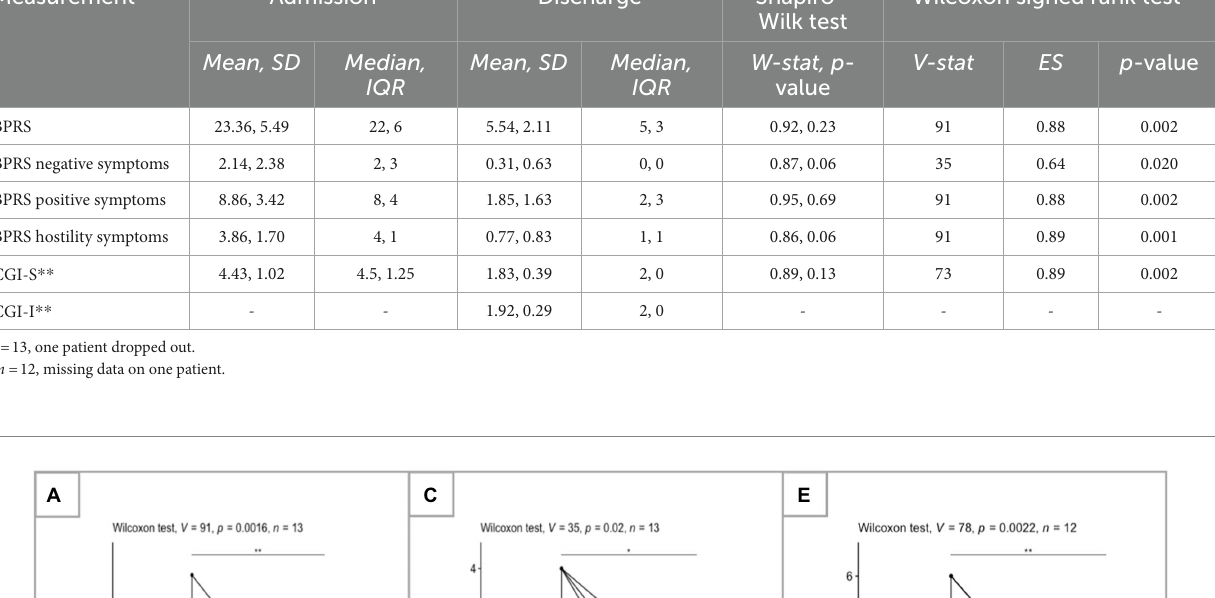
TABLE 2 Changes between admission and discharge.